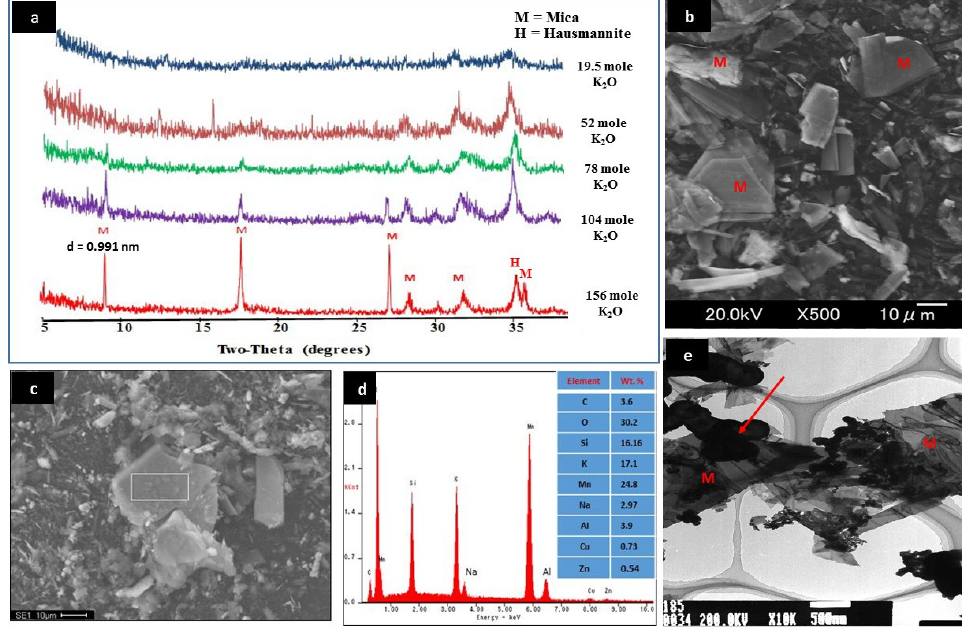
Figure 1. Effect of K 2 O moles on the crystallization of Mn ‒ mica as revealed by XRD patterns ( a ), scanning electron microscopy (SEM) ( b ), energy-dispersive X-ray spectroscopy (EDX) ( c , d ), and